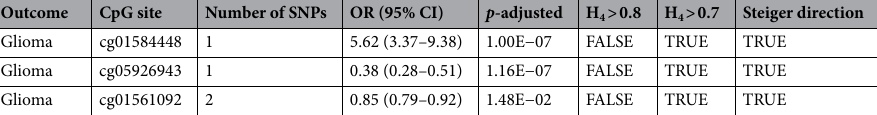
Table 2. CpG sites that met the FDR correction threshold (p-value < 0.05) in the MR analyses of glioma risk, showed evidence of colocalization (H 4 > 0.7) and the correct direction of effect. OR odds ratio per standard deviation change in methylation, 95% CI 95% confidence intervals, p-value p-value for the observed effect, SNP single nucleotide polymorphism.